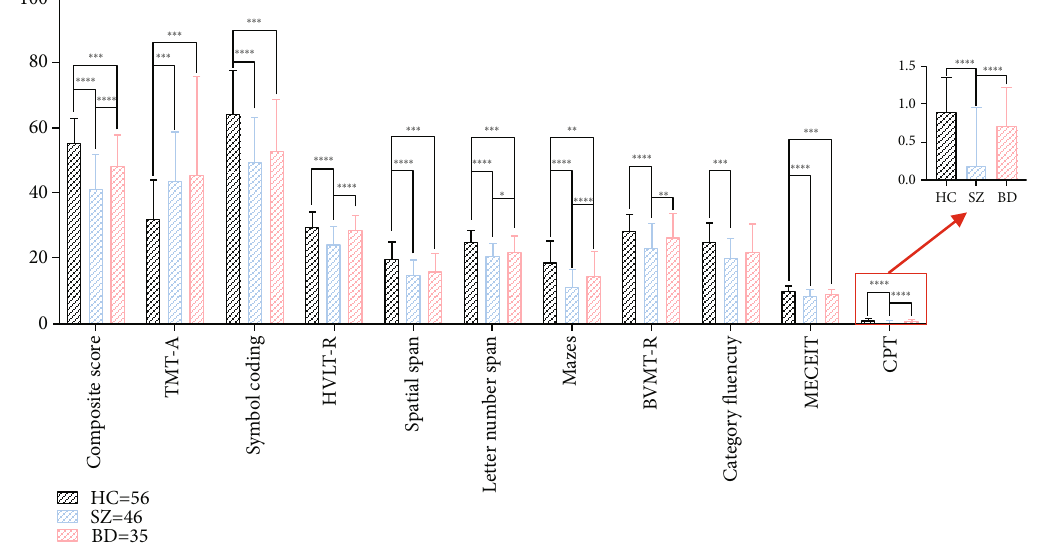
Figure 1: MCCB subtest scores comparison among BD, SZ and HC. TMT-A, Trail Making Test A; HVLT-R, Hopkins Verbal Learning Test- Revised; BVMT-R, Brief Visuospatial Memory Test-Revised; MSCEIT, Mayer – Salovey – Caruso Emotional Intelligence Test; CPT-IP, Continuous Performance Test-Identical Pairs. Note: ∗ p < 0 : 05 , ∗∗ p < 0 : 01 , ∗∗∗ p < 0 : 005 , ∗∗∗ ∗ p < 0 : 001